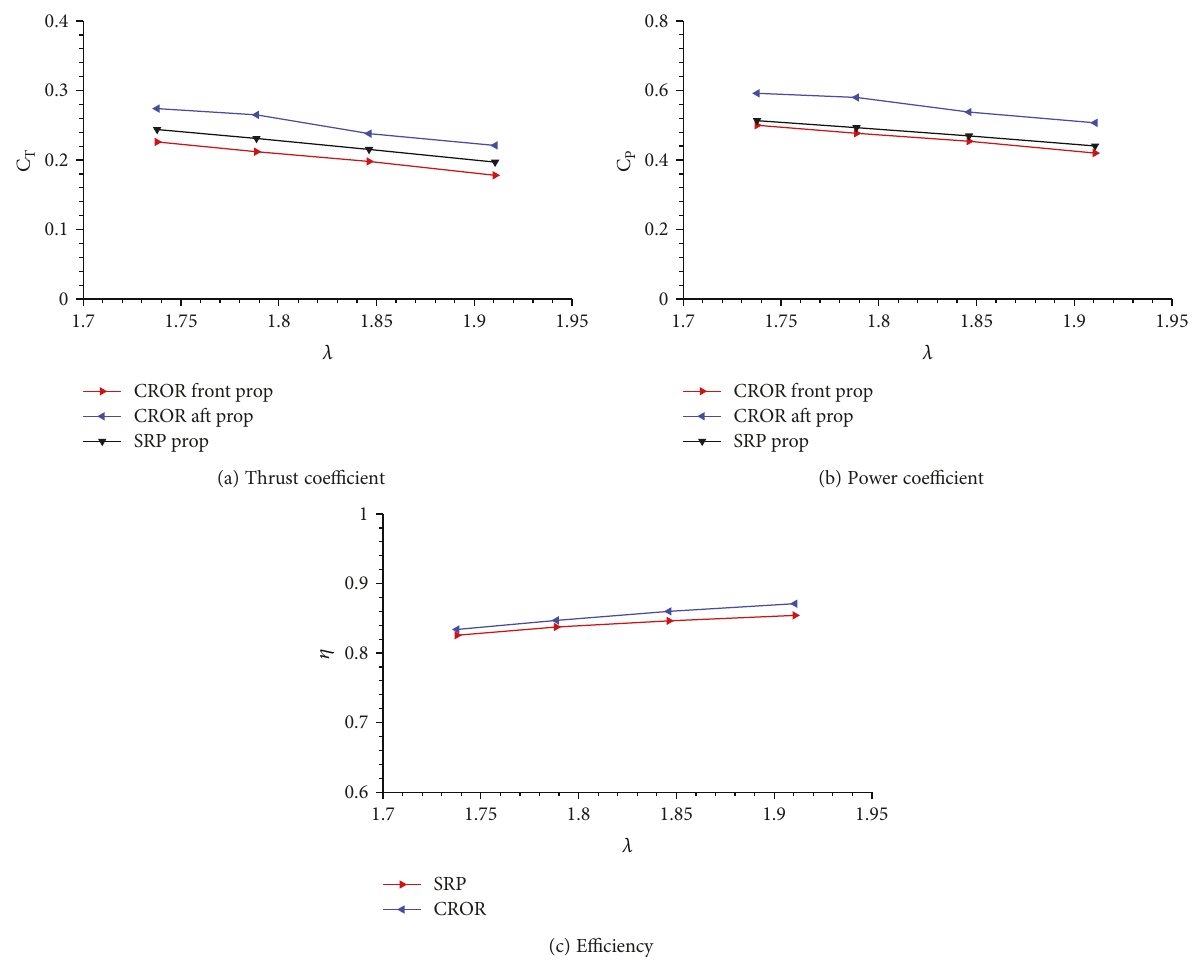
Figure 16: Comparison of CROR and SRP